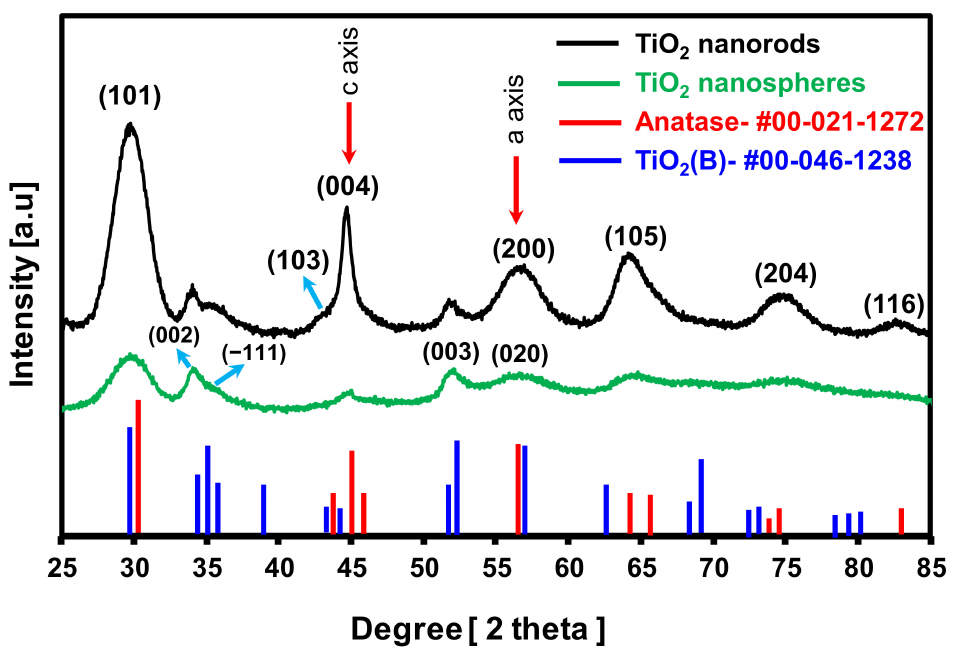
Figure 4. XRD patterns of synthesized TiO 2 NRs and semispherical NCs. Bragg peaks at 30.5 ◦ , 45.4 ◦ , 57.0 ◦ , 64.6 ◦ , 66.1 ◦ , and 74.6 ◦ indicate the existence of the anatase phase of TiO 2 (JCPDS No.01-086- 1155) for NRs. XRD analyses clearly show the occurrence of other Bragg peaks at 34.6 ◦ , 35.9 ◦ , 52.7 ◦ , and 57.9 ◦ mainly due to semispherical NCs that are fit with the TiO 2 (B) phase of titania with the reference card (JCPDS-00-046-1238). The (002), ( − 111), (003), and (020) reflections are typical of TiO 2 (B)